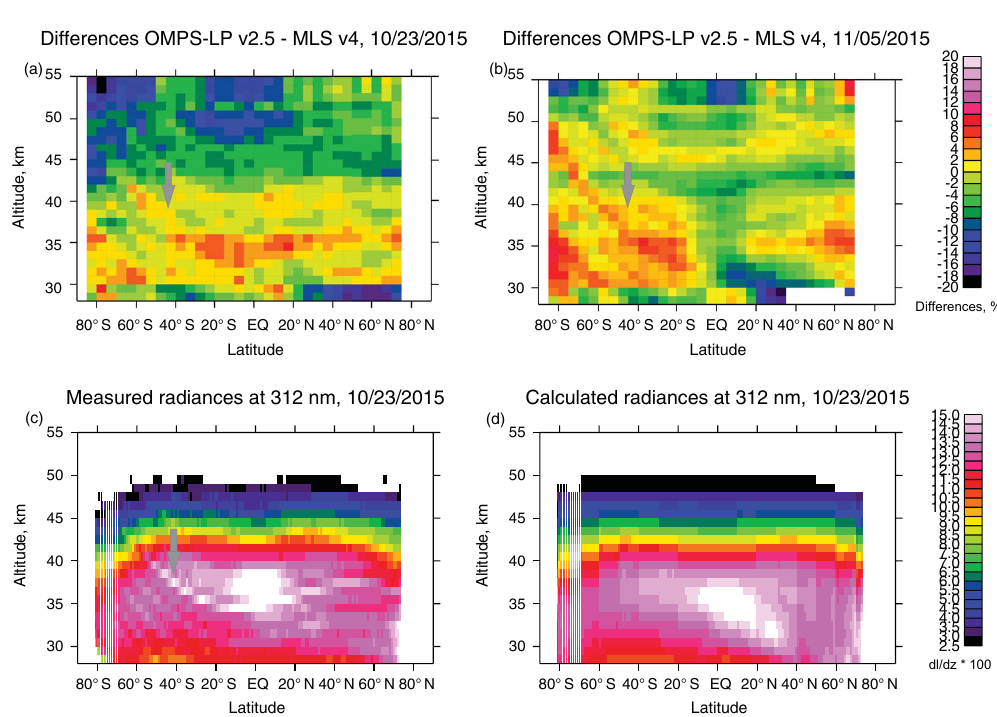
Figure 3. Panels (a–b) show mean differences (%) between LP and MLS ozone profiles on 23 October 2015 and 2 weeks later on 5 Novem- ber 2015. The grey arrows show one of the artificial structures found in LP ozone retrievals that repeat from orbit to orbit with remarkable precision. Panels (c–d) show results of the internal analysis of measured (c) and calculated (d) radiances at 312nm on 23 October 2015. The subtle structures in measured radiances (not seen in calculated radiances) mimic structures observed in LP ozone retrievals.